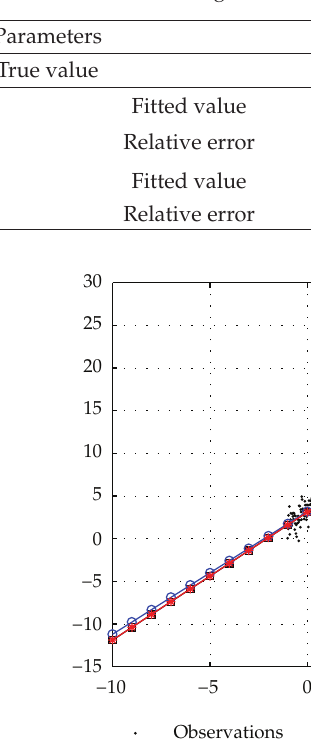
Table 2: Two-stage estimates for β 0 and β 1 of GLS and OLS.